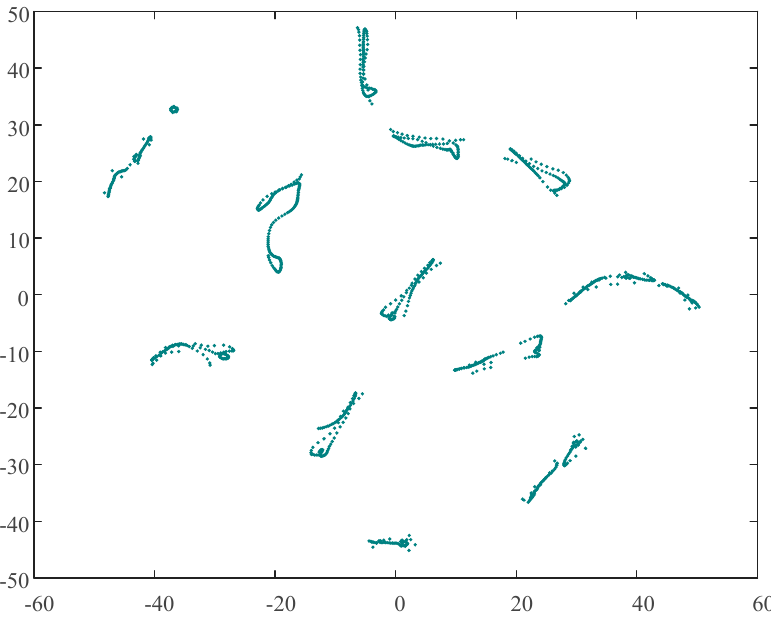
Figure 9. The 2D map of the sheath current matrix V .